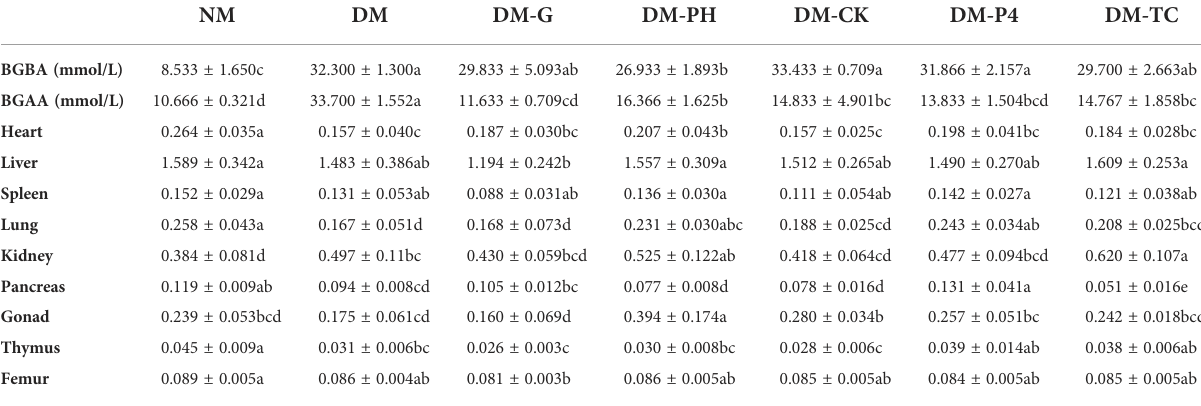
TABLE 3 The blood glucose and organ weight (g) of mice under different treatments.